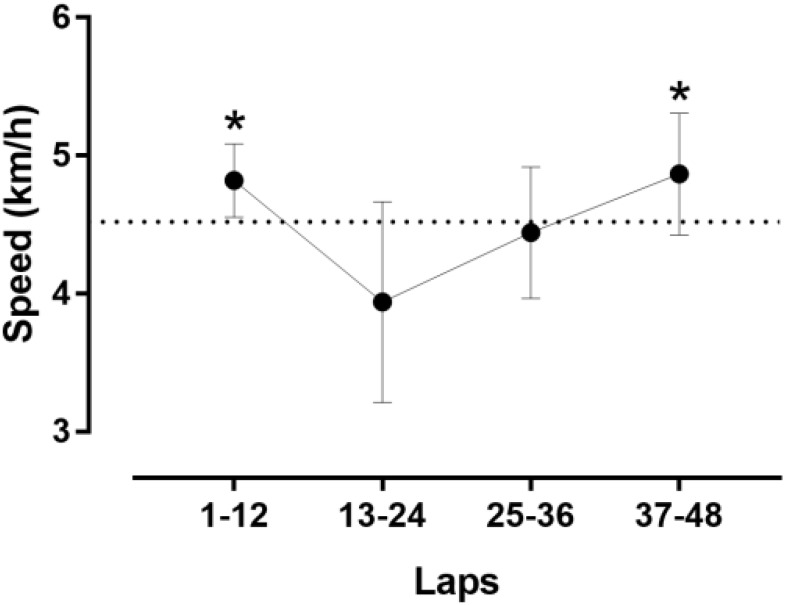
Speed by quartiles of laps.∗different from the second quartile at p < 0.05. Error bars represent standard deviations.